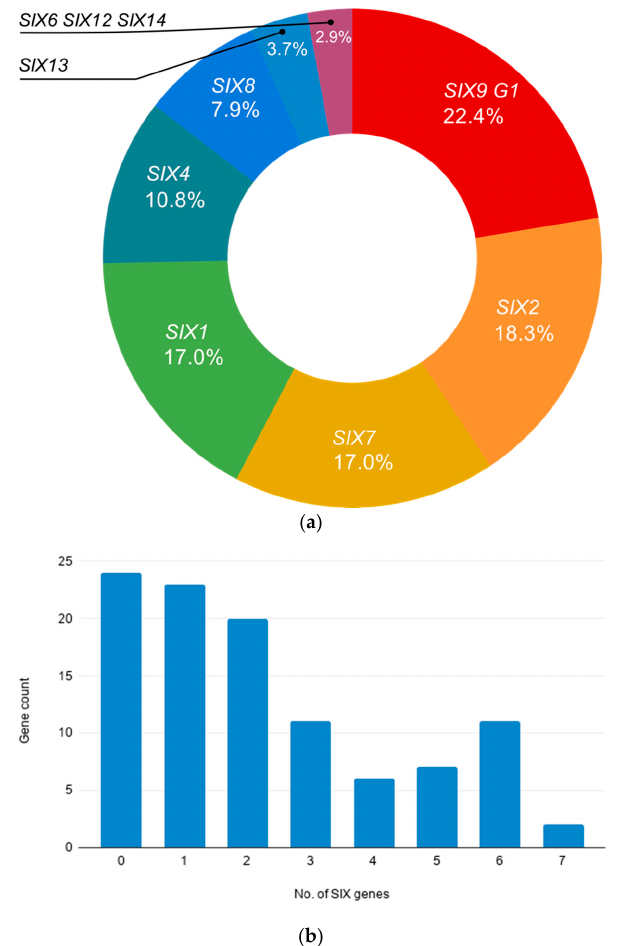
Figure 2. Summary of secreted in xylem ( SIX ) gene presence in isolates of Fusarium isolated in this study. ( a ) Frequency of SIX gene presence in isolates of Fusarium recovered from the tissue of field banana plants. ( b ) Summary of the number of SIX genes identified in isolates of Fusarium associated with healthy, asymptomatic banana plants.